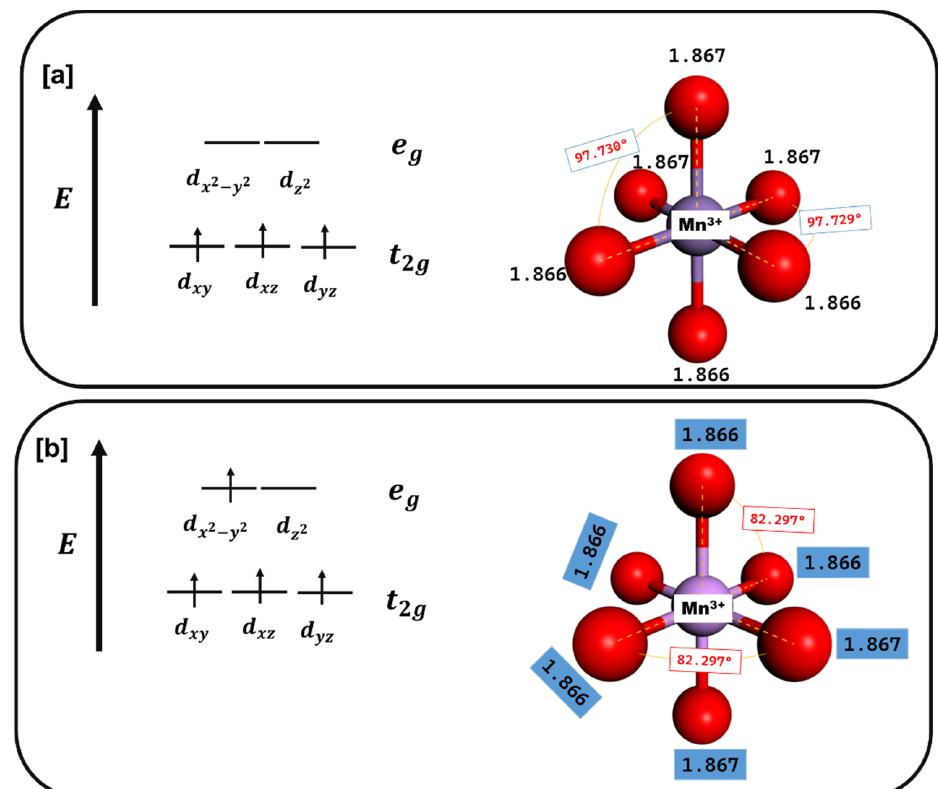
Figure 2. The manganese and oxygen octahedron in the LiMn 2 O 4 spinel framework showing the ( a ) Mn 4+ and ( b ) Mn 3+ states. Illustration of the Mn–O bond distances, the O–Mn–O angles capturing the MnO 6 octahedral environment and the electronic configuration of Mn 4+ and Mn 3+ .